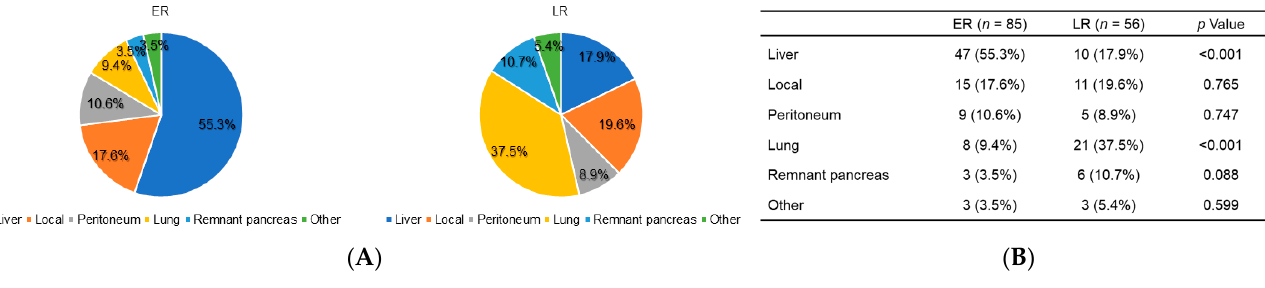
Figure 3. ( A ) Proportion of first recurrence sites and ( B ) comparison of the recurrence patterns at different time points.